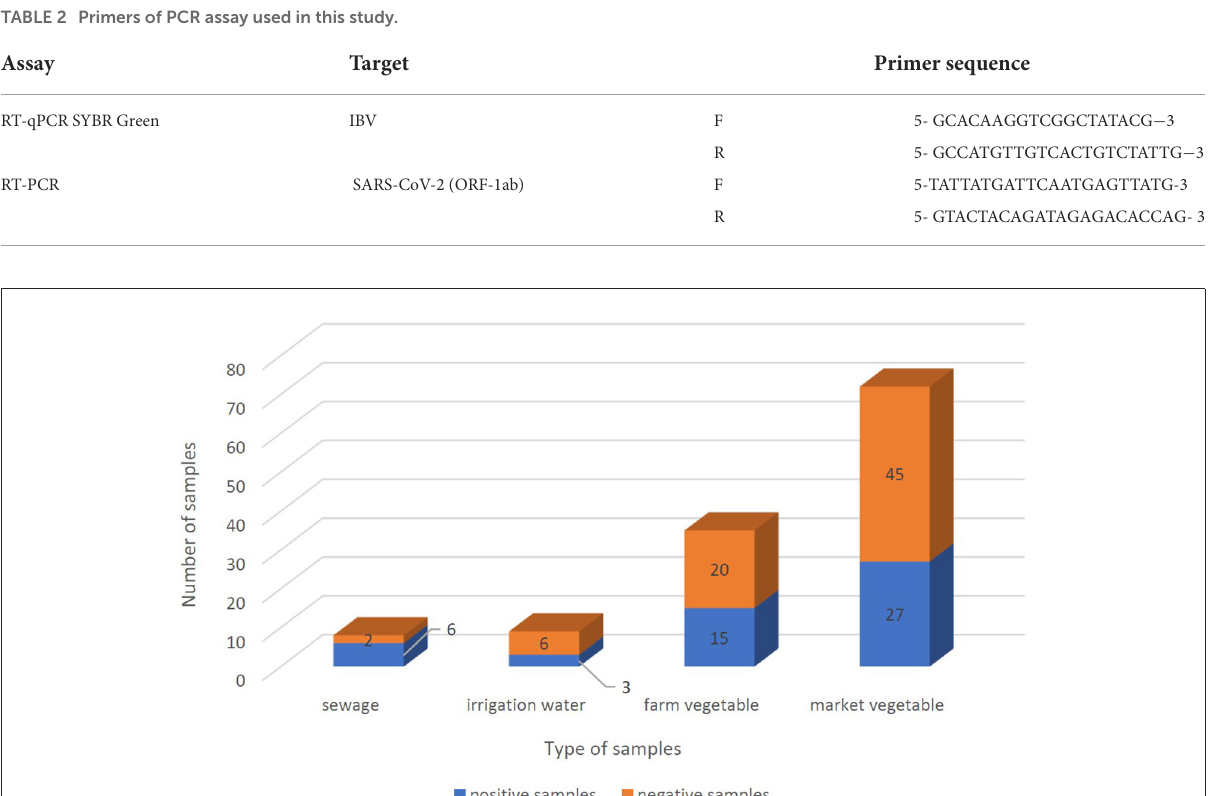
samples, the RdRp gene was examined, and its CT ranged from 30.54 to 39.22. RdRp gene compared to the N gene, a better